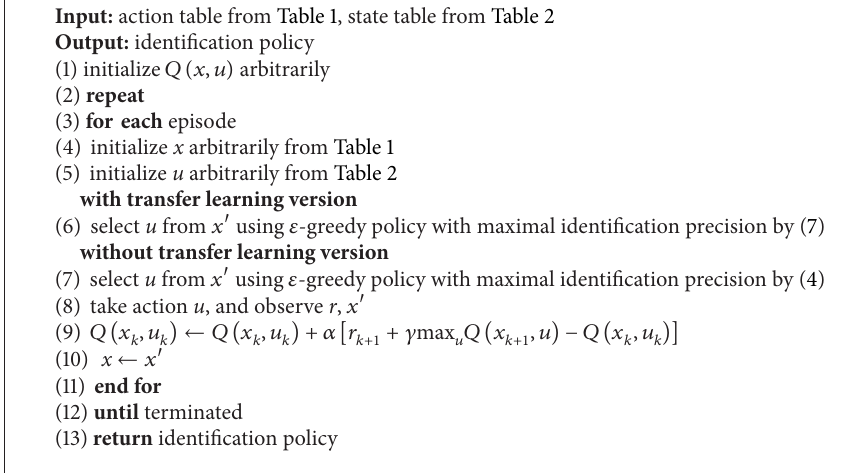
Algorithm 2: Unregistered biological terms identification by Q-learning with transfer learning.